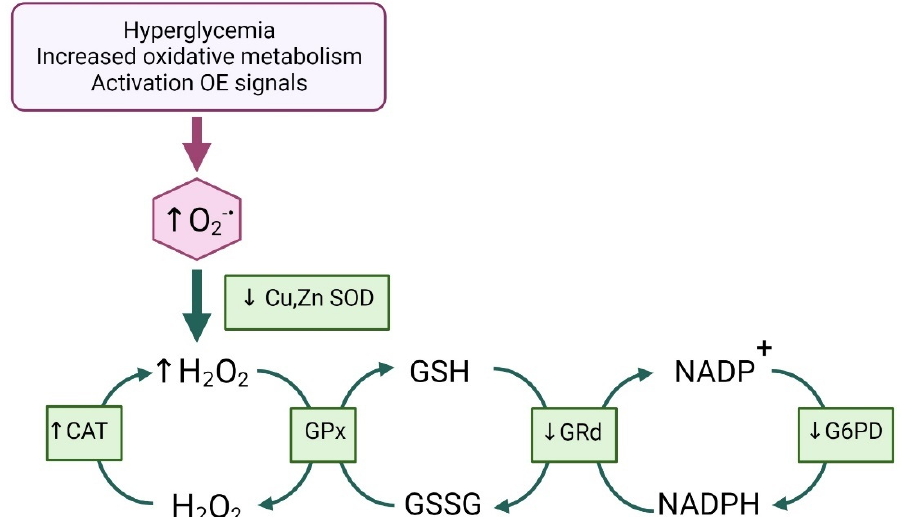
Figure 7. Summary of redox status changes detected in the population studied. Significant reduction of glucose-sensitive SOD activity causes an increase in CAT compensative activity, and GPx activity tends to increase. Decreased G6PD activity limits NADPH levels, contributing to the reduction of GRd activity, which leads to an increased GSSG/GSH ratio. All arrows indicate the directions of biochemical reactions. Created with BioRender.com, (accessed on 16 August 2022).